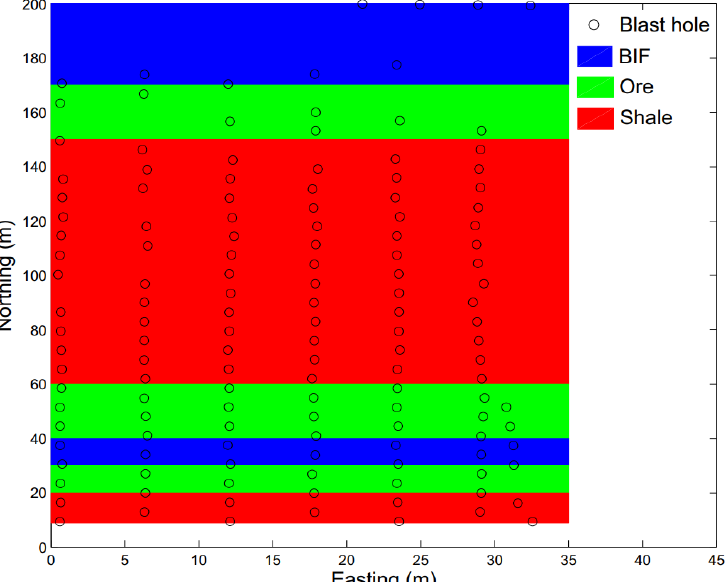
Figure 8. Rock type boundary “ground truth” of the experimental real mining site data. Reprinted with permission from [17]. Copyright Hang Zhou, 2011.